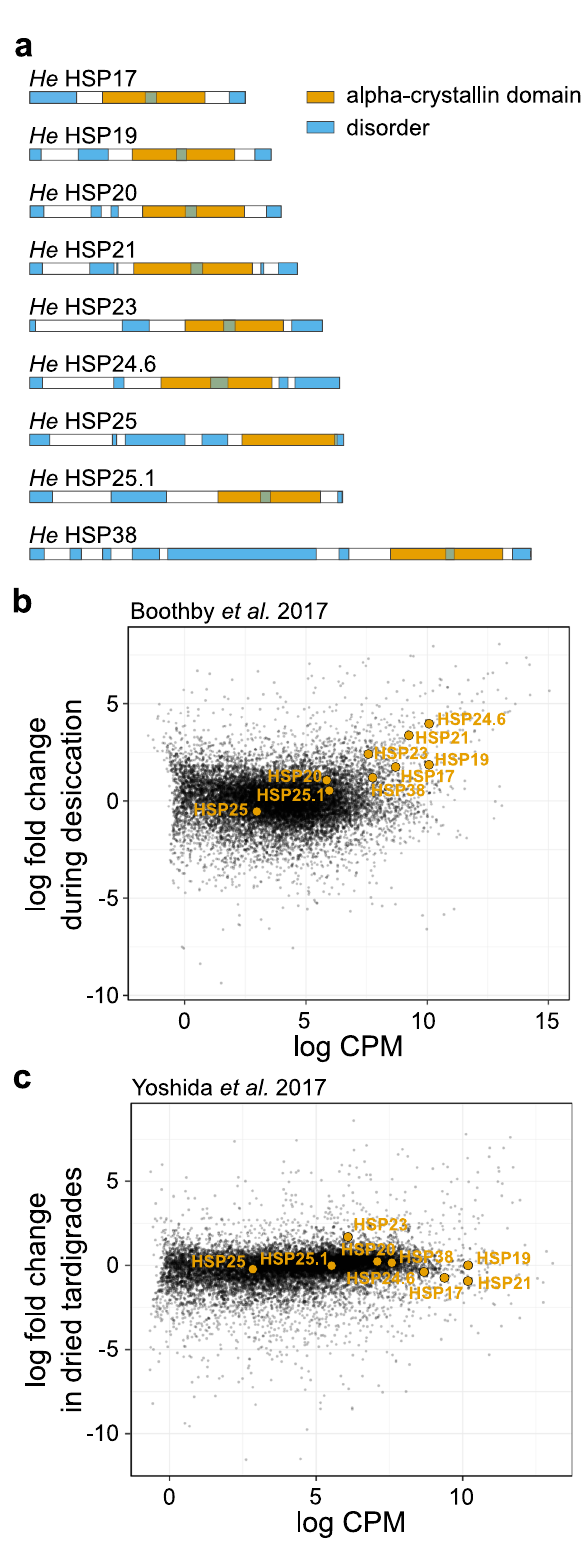
Fig. 1 The tardigrade Hypsibius exemplaris has nine small heat shock proteins, several of which are highly expressed. a Nine sHSPs were identi fi ed that conform to the typical structure containing an alpha- crystallin domain fl anked by disordered N-terminal and C-terminal domains. b Seven of nine sHSPs were upregulated during desiccation in RNA-seq data from Boothby et al. 2017 (HSP17, HSP19, HSP20, HSP21, HSP23, HSP24.6, and HSP38, FDR < 0.01). sHSP transcripts are highlighted on a plot of expression fold-change compared to relative abundance from mRNA-seq. c Only one sHSP (HSP23) was signi fi cantly upregulated during desiccation (FDR < 0.01) in RNA-seq data from Yoshida et